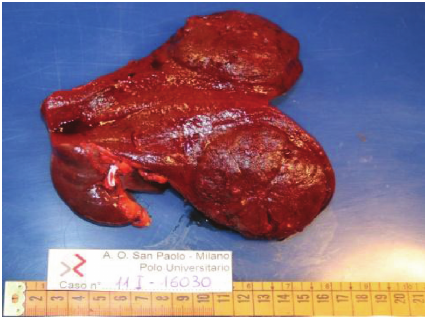
Figure 3: The removed specimen: spleen with a round capsulated nodule of increased sti ff